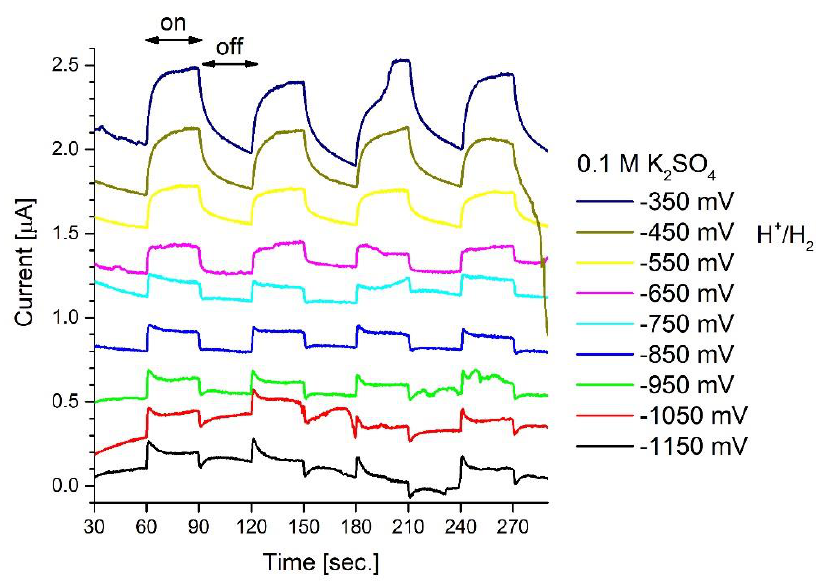
Figure 9. Photoelectrochemical experiments in 0.1 M K 2 SO 4 (pH = 6.8) from −350 to −1150 mV vs. SHE. The potential for the H + /H 2 couple was determined at −401 mV considering a pH = 6.8. Illumination profile: 30 s light on and 30 s light off. All the experiments are stacked at a constant value of 0.2 µA on the y-axis.